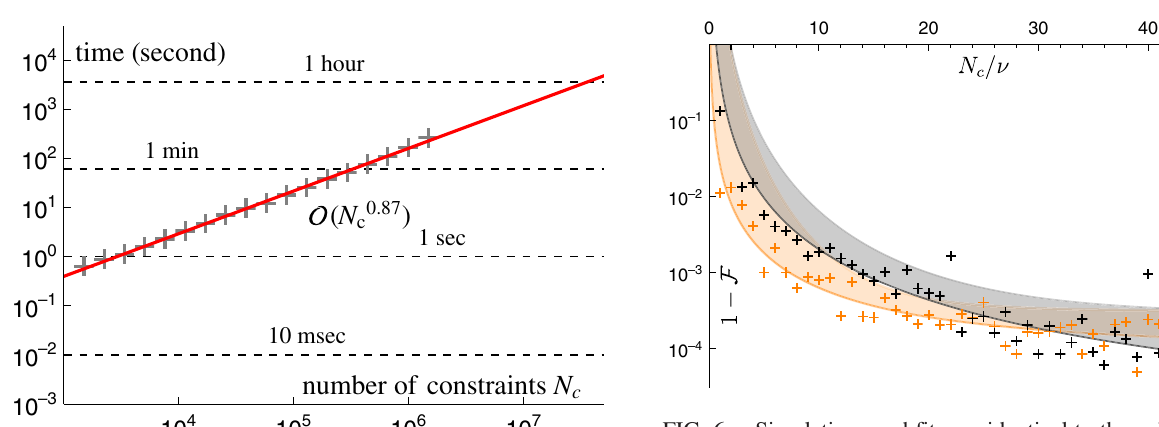
FIG. 6. Simulations and fits are identical to those in Fig. 3 but now with added noise. Orange shows results including a shot 10 5 shots, modeled as independent Gaussian FIG. 5. Computation time with a Mathematica code of the noise for N s ¼ ˜ J − 1 f update rule Δ θ ¼ via the regularized inverse of the non- noise on all expectation values. At small N , shot noise c ˜ J ∈ R 2 N ν with a fixed number of circuit square matrix Jacobian regularizes the ill-conditioned linear system of equations and c × parameters ν ¼ 1000 and increasing number of constraints does seemingly improve performance. Black results show the (covariances) N . The time complexity is O ð N linear in the performance of CoVaR under simulated circuit noise as described c c Þ leading dimension, as the number of constraints and the absolute in Appendix E 2, indicating the resilience of the method to time is very reasonable, i.e., less than an hour even for very large reasonable levels of circuit noise. In the large- N limit, a noise c 10 7 (computed with a desktop PC). floor is approached whose magnitude in our particular example is matrices with N c ¼ comparable for both cases of only shot noise (orange) and only circuit noise (black) — large spread of the data points is due to our randomly generated constraints, and fits of the best (solid curves) and worst (shaded area) of three runs of CoVaR are